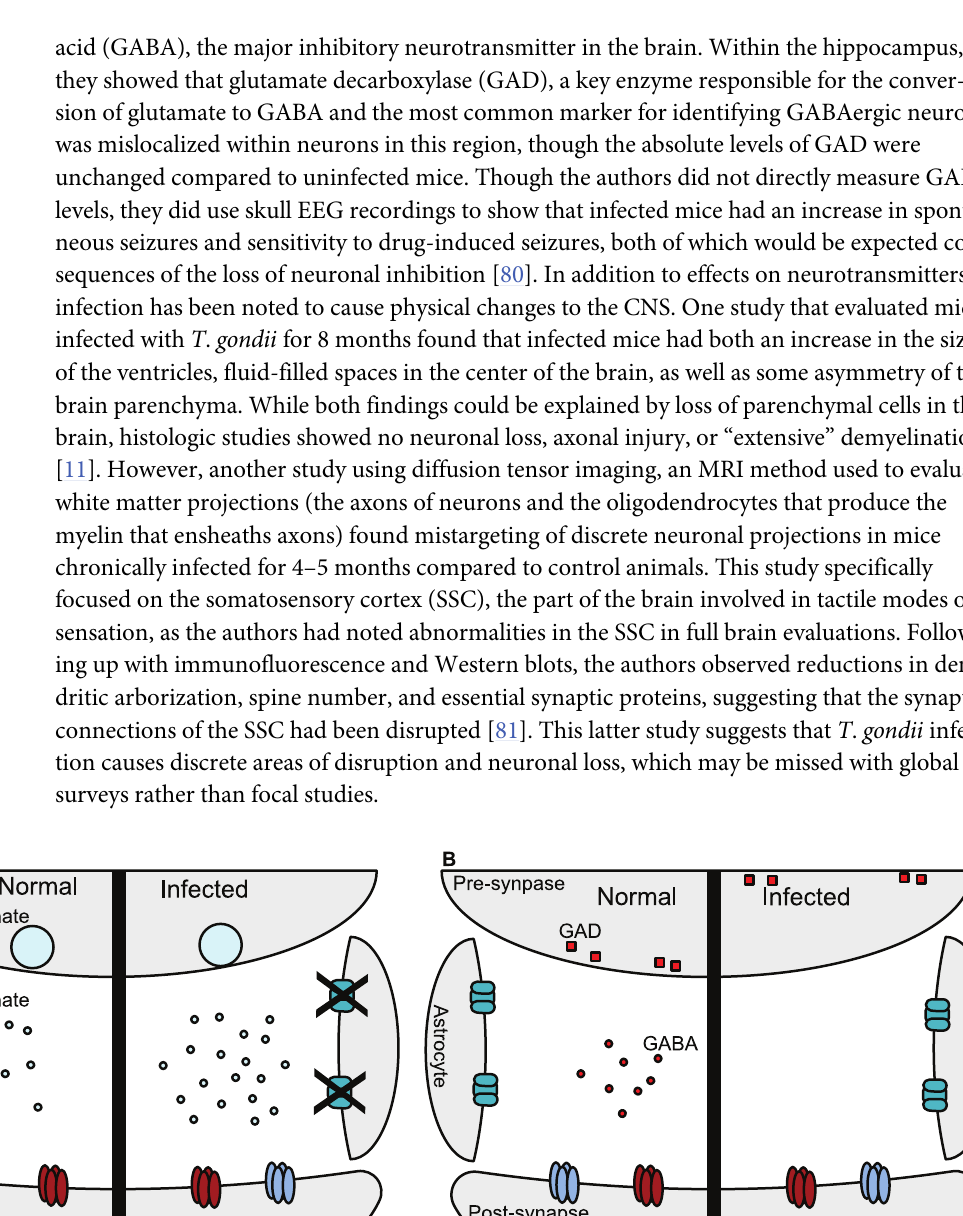
PLOS Pathogens| https://doi.org/10.1371/journal.ppat.1006351 July 20,